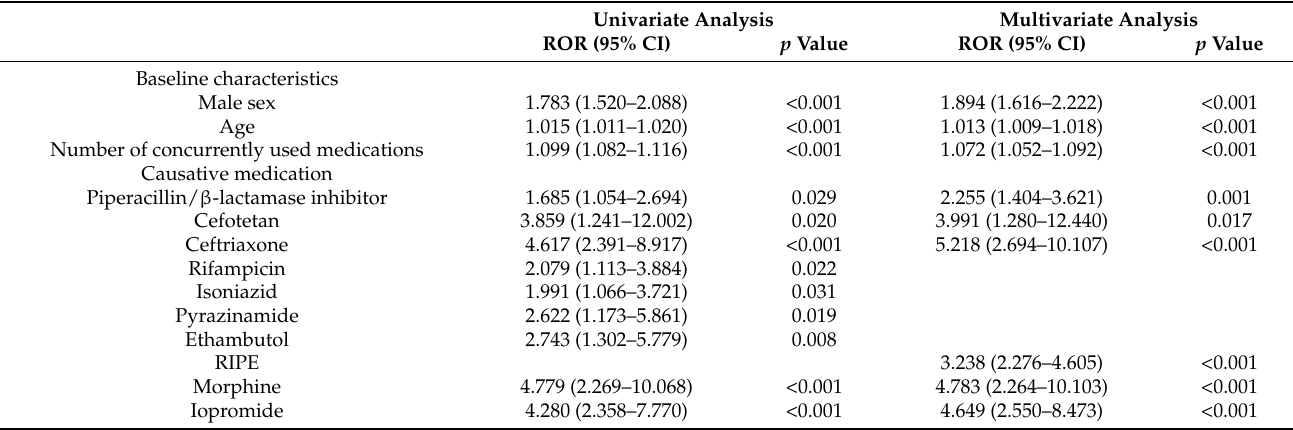
Table 3. Univariate and multivariate analyses for the association of fatal adverse drug reactions with patient characteristics and causative